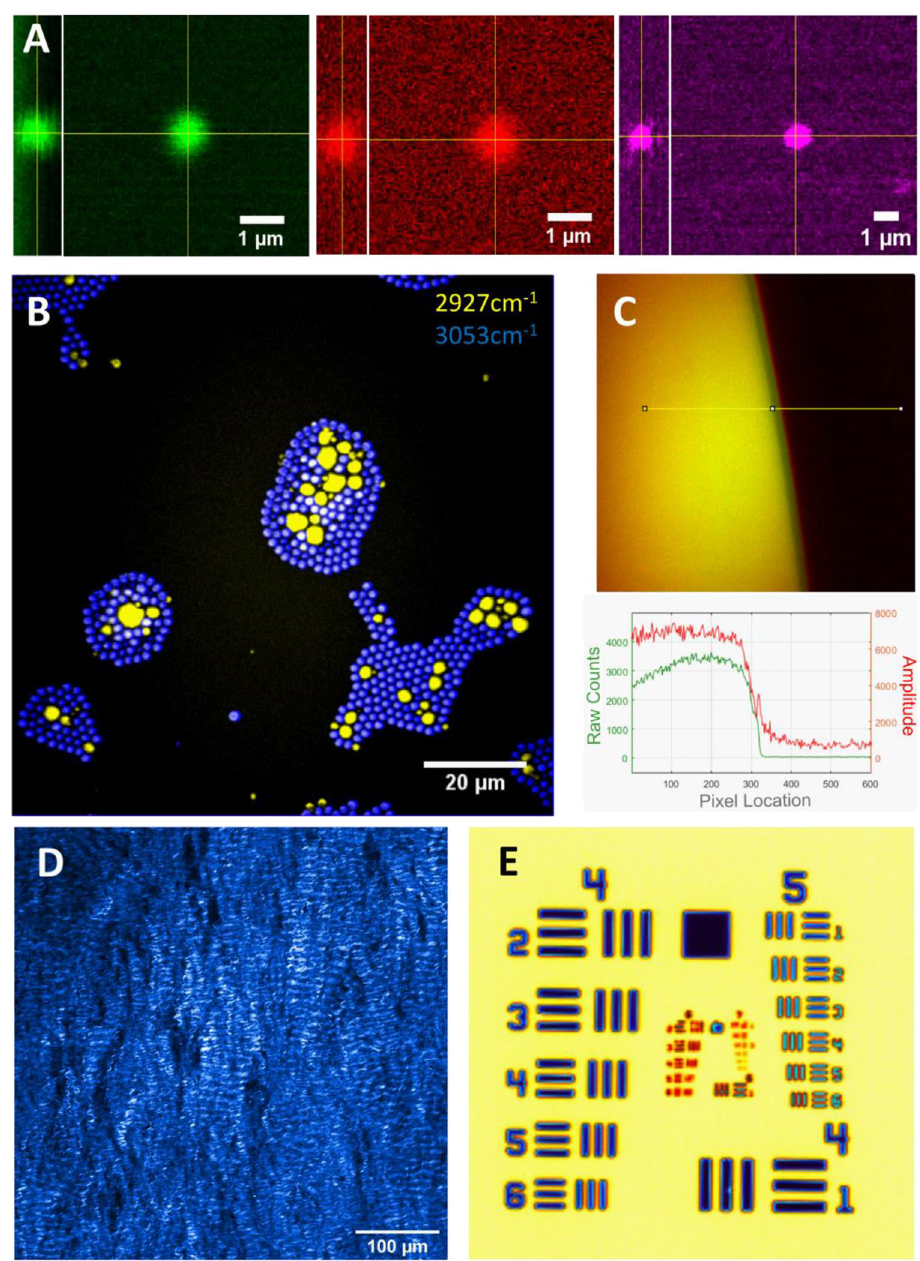
Figure 2. MANTIS system performance. ( A ) Resolution of CARS (Green), SRS (Red) with a 1 µm polystyrene bead, and Multiphoton Fluorescence (Magenta) with a 500 nm yellow-fluorescent polystyrene bead. Measured resolutions summarized in Table S1. ( B ) Preparation of mixed beads containing 2 µm polystyrene beads (blue, 2927 cm −1 ) with 1–10 µm PMMA beads (yellow, 3053 cm −1 ). Peaks specific to each bead type ( C ) CARS (Green) and SRS (Red) of signal-to-noise profile measured at a vegetable oil–air meniscus at 2927 cm −1 . ( D ) SHG imaging of a porcine mitral valve ex vivo. ( E ) Thermal Imaging of a 1951 U.S. Air Force